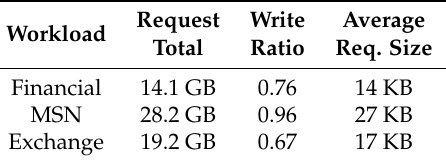
Table 2. Characteristics of I/O